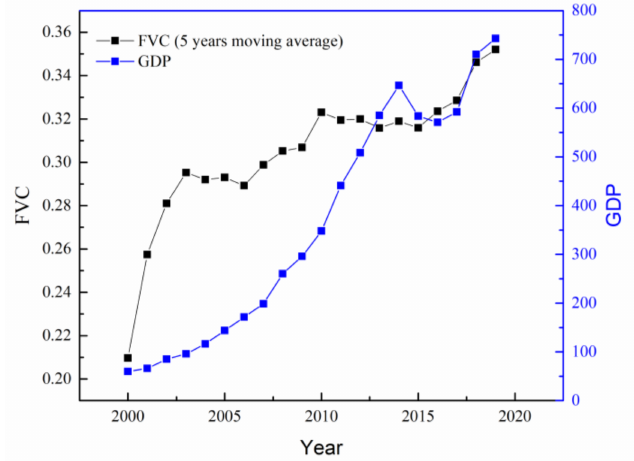
Figure 16. Relationship between FVC and GDP from 2000–2020 in